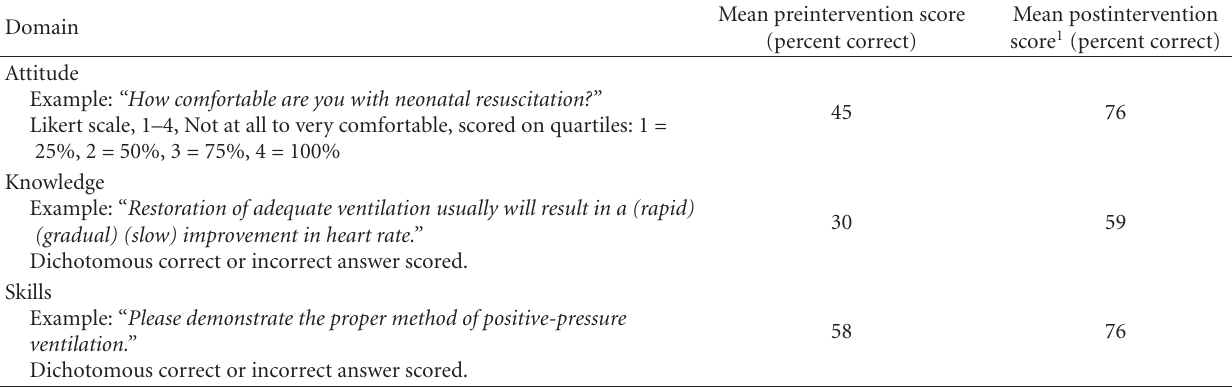
Table 2: Changes in trainees’ attitude, knowledge, and skills in neonatal resuscitation.